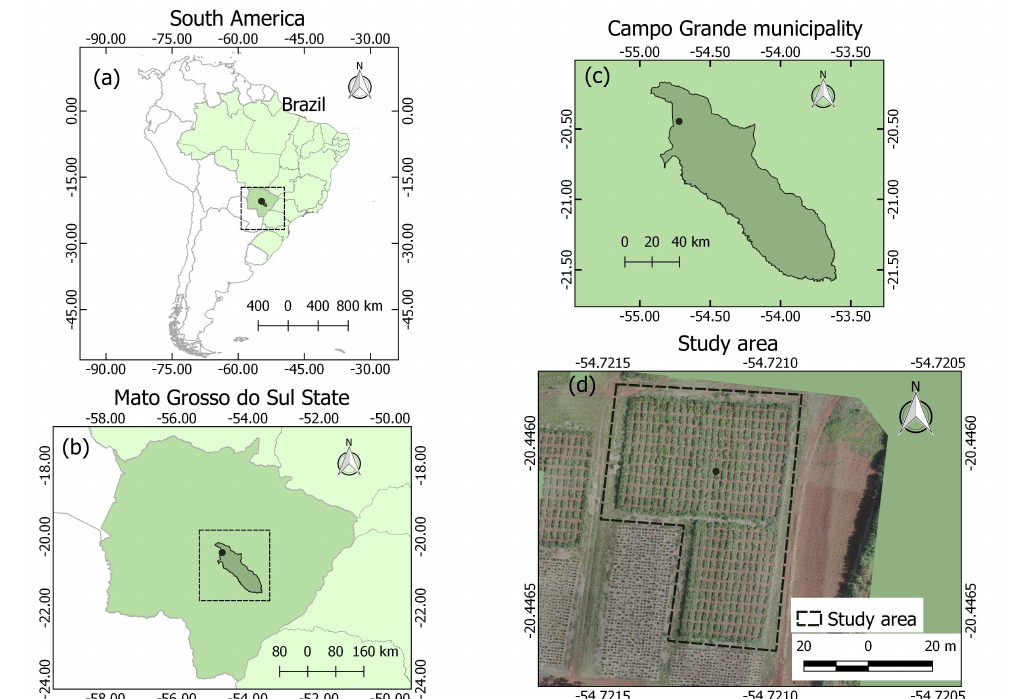
Figure 1. Dataset location considering WGS-84 reference system: ( a ) South America/Brazil; ( b ) Mato Grosso do Sul State; ( c ) Campo Grande municipality and; ( d ) Study area.